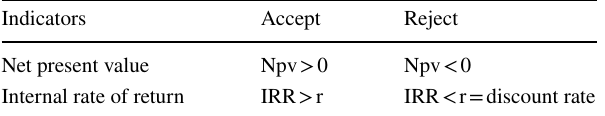
Table 4 Investment Decision